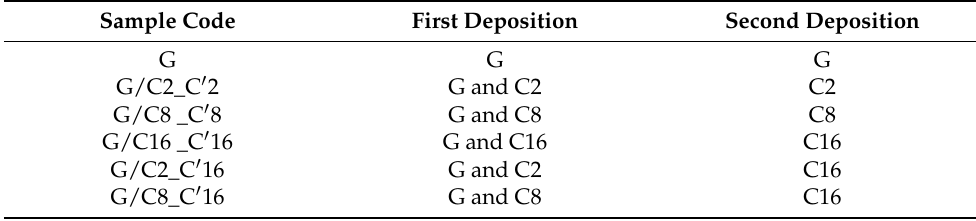
Table 1. Composition of the functional nanohybrid sols of each